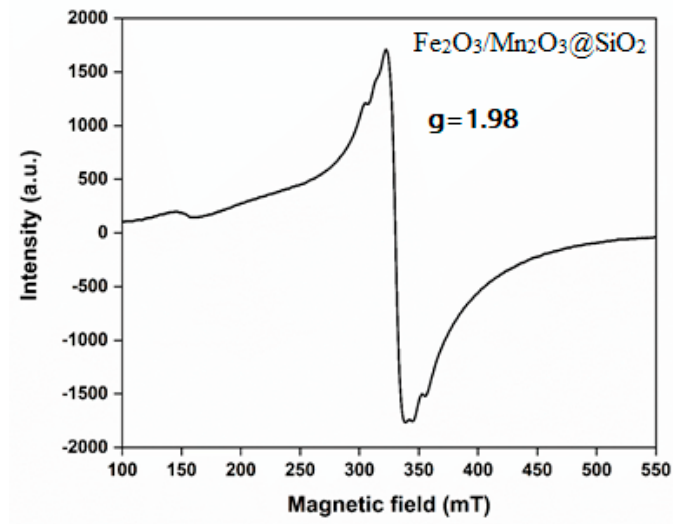
Figure 4. ESR spectrum of synthesized photocatalyst Fe 2 O 3 /Mn 2 O 3 @SiO 2 (FMS).